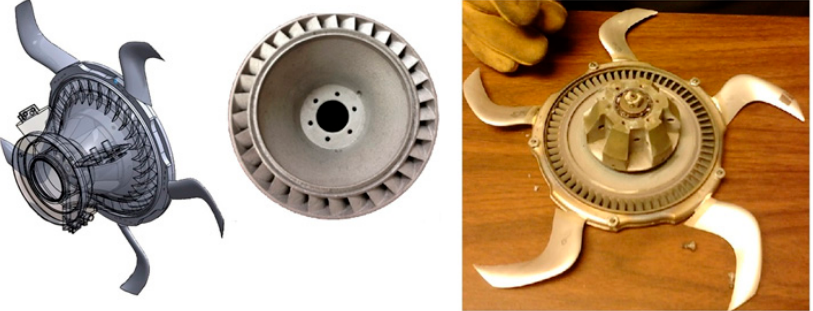
Figure 34. Swept propeller with supercritical NASA airfoil near the tip to avoid shockwave.